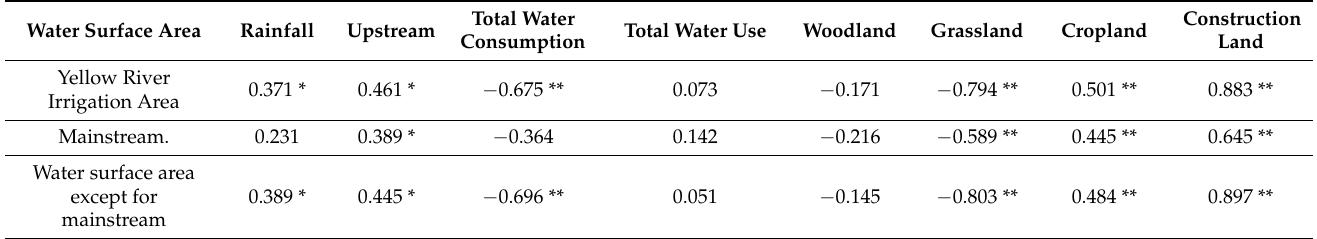
Table 3. Correlation results between water surface area and other